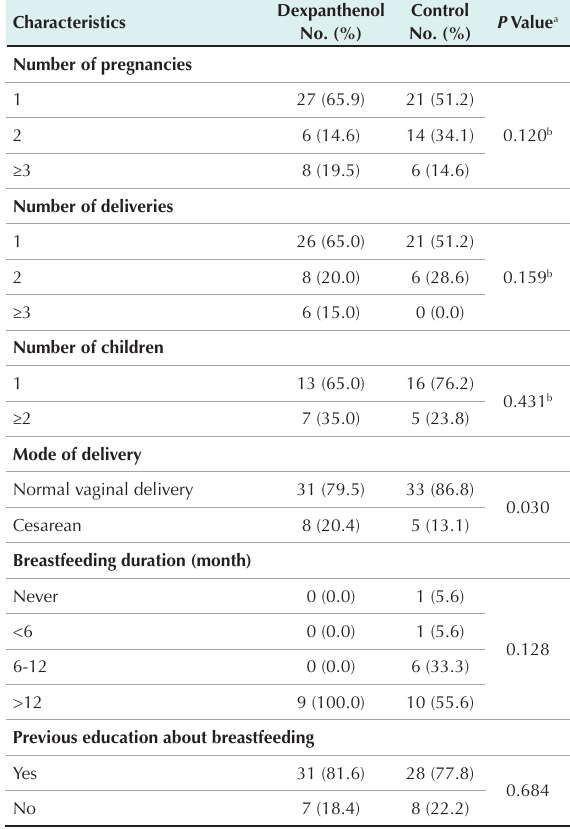
Table 2. Obstetric and Breastfeeding Characteristics of Participants